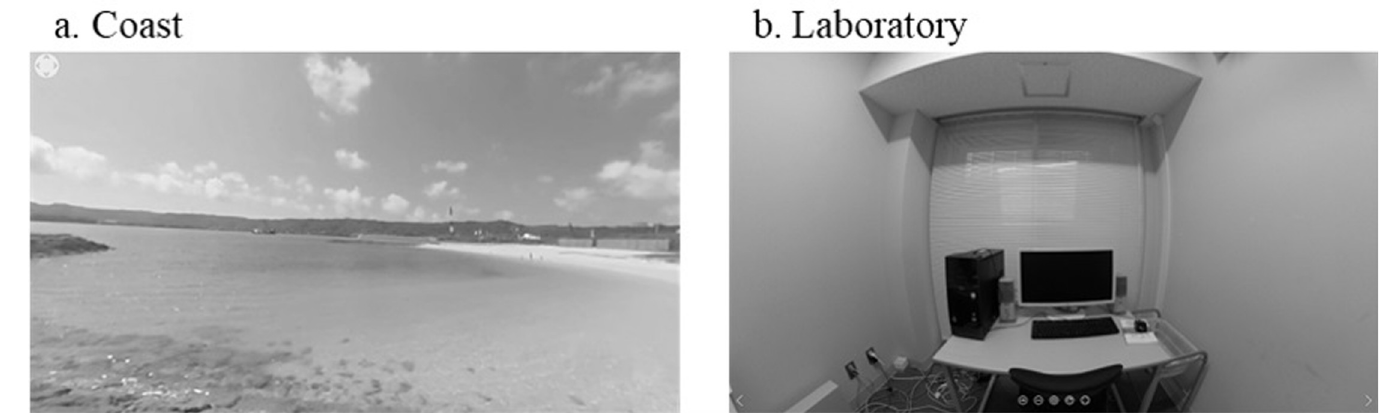
Fig 1. View of (a) the 360˚ video of the coast and (b) the